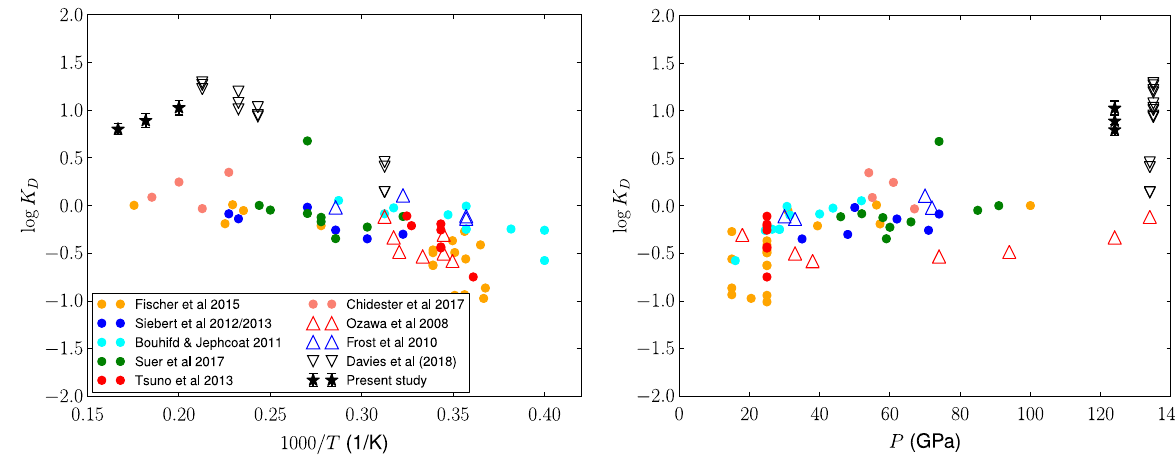
FIG. 2. Comparison of present results with published work. Panels show values of the distribution coefficient K D plotted against inverse temperature (left) and pressure (right) for our data together with other experimental studies of solid-silicate – liquid-metal partitioning (open symbols) and silicate-melt – liquid-metal partitioning (closed